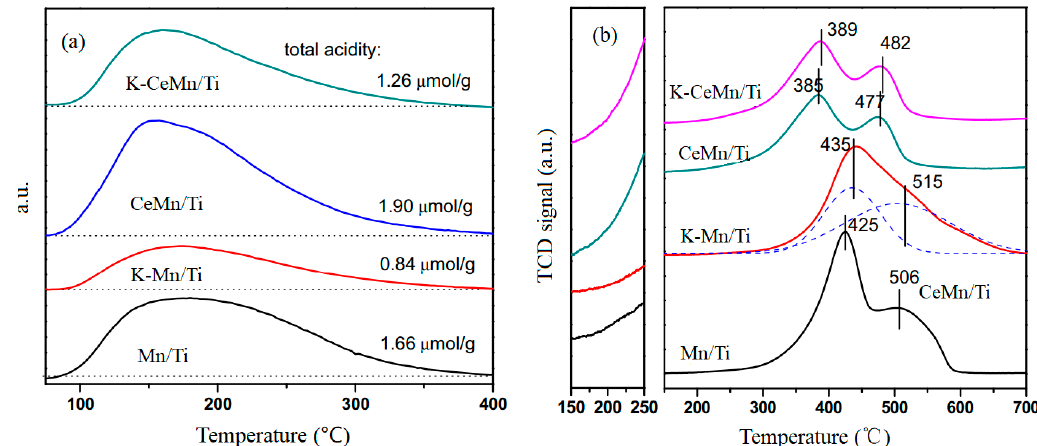
Figure 11. ( a ) NH 3 -TPD profiles of fresh and poisoned catalysts in the range of 75–400 °C and ( b ) H 2 -TPR profiles of fresh and poisoned catalysts in the range of 150–700 °C [80].